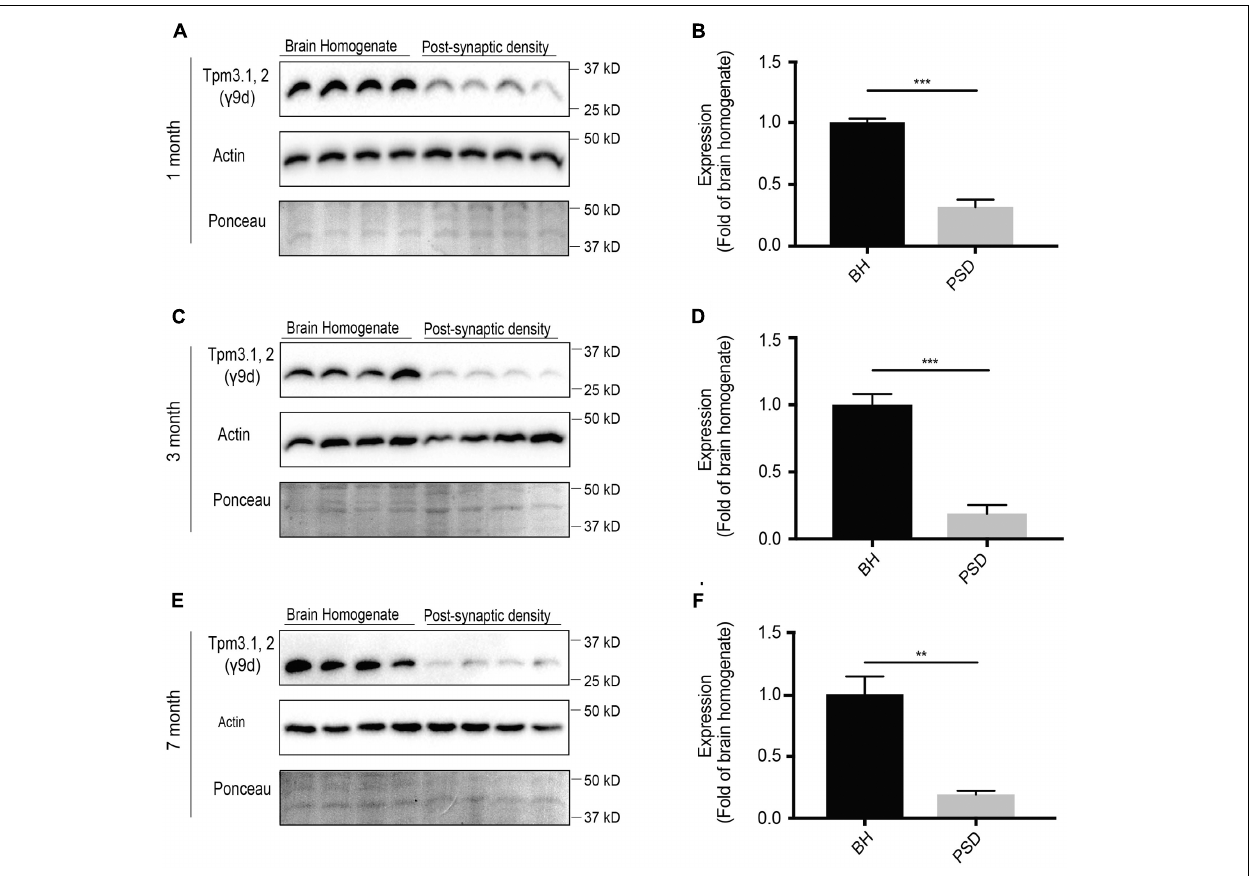
FIGURE 7 | Western blot analysis of expression profile of Tpm3.1 and Tpm3.2 utilizing the polyclonal γ 9d sheep antibody in the brain homogenate and post-synaptic density (PSD) of wild type mouse brains. (A) Western blots of 1-month-old brain homogenate and PSD fractions. (B) Quantification of (A) normalized to expression in the brain homogenate. (C) Western blots of 3-months-old old brain homogenate and PSD fractions. (D) Quantification of (C) normalized to expression in the brain homogenate. (E) Western blot of 7-months-old brain homogenate and PSD fractions. (F) Quantification of ( E ) normalized to expression in the brain homogenate. Total actin and Ponceau staining show equal loading. (mean ± SEM, n = 4, ∗∗ P < 0.01, ∗∗∗ P <